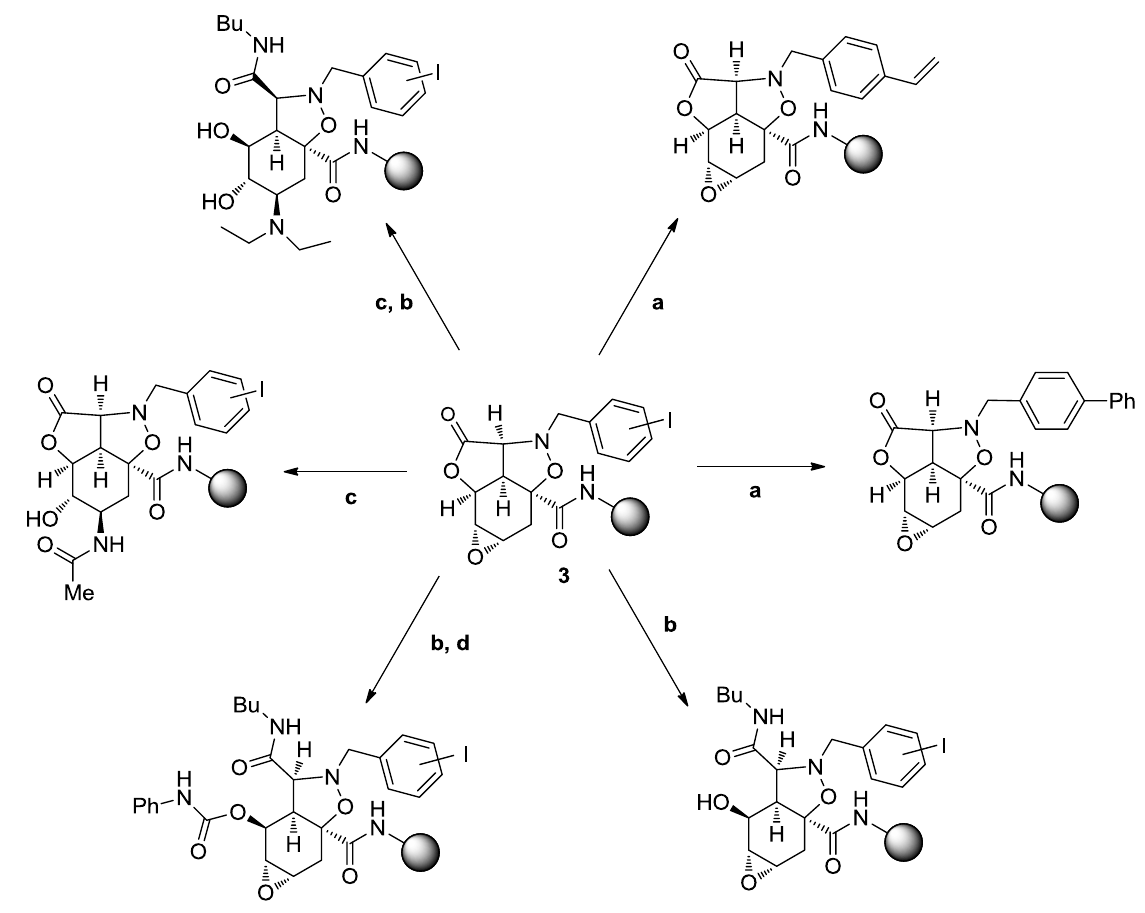
Scheme 2. Potential sites of functionalization and representative examples of compounds derived from template 3 by ( a ) cross-coupling reactions, ( b ) aminolysis of lactone moiety, ( c ) epoxide ring opening and ( d ) alcohol esterification